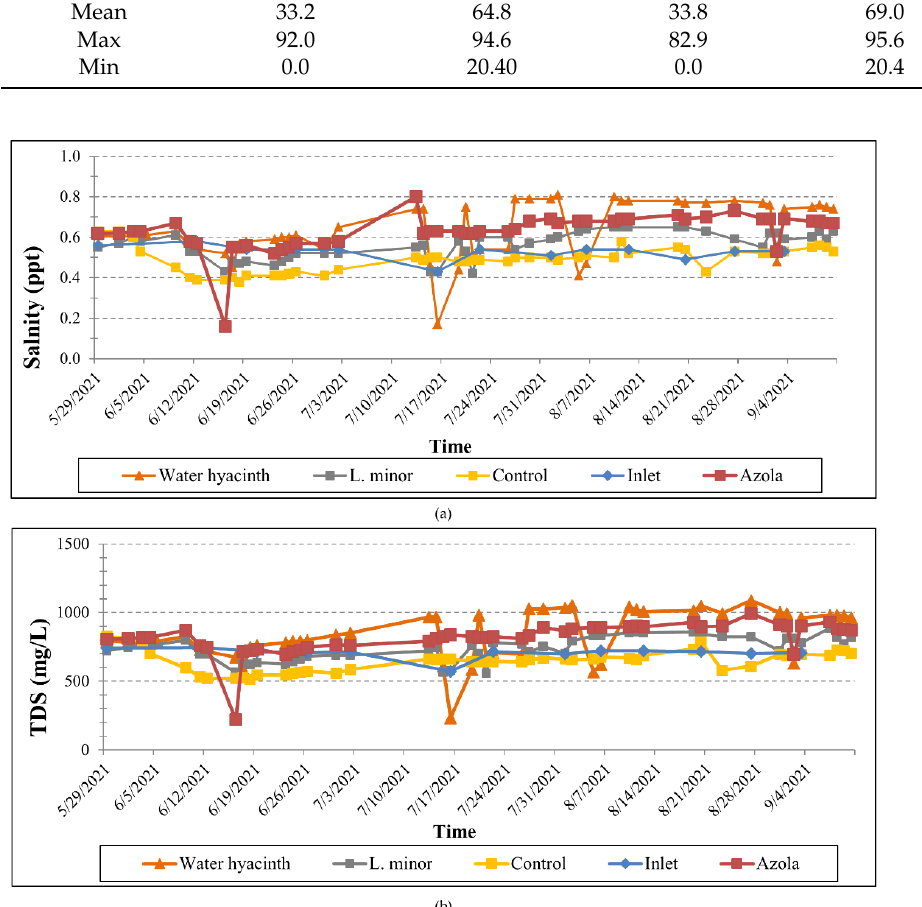
Figure 4. Temporal variation of ( a ) salinity and ( b ) total dissolved solids at the inlet and the outlet of the four tanks throughout the operation period.